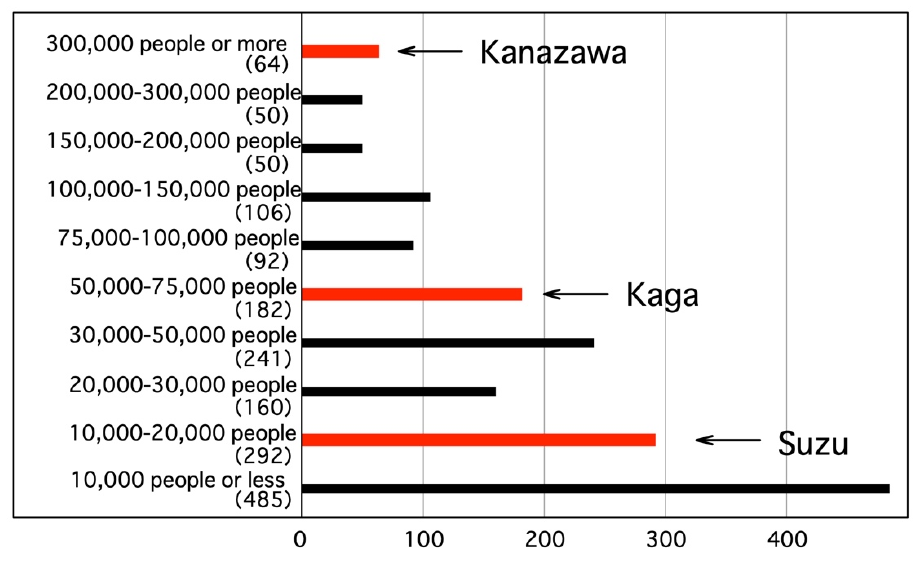
Figure 2. Populations of target cities and nationwide ranking (unit: persons). Kanazawa has an urban structure centered on the old castle ruins and has diverse regional characteristics (Figure 3). There are 21 secondary medical institutions (hospitals)